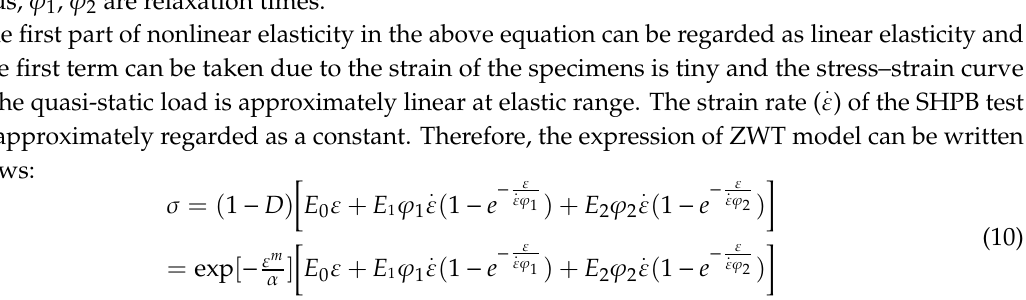
Table 5. Inversion results of ZWT model parameters under di ff erent